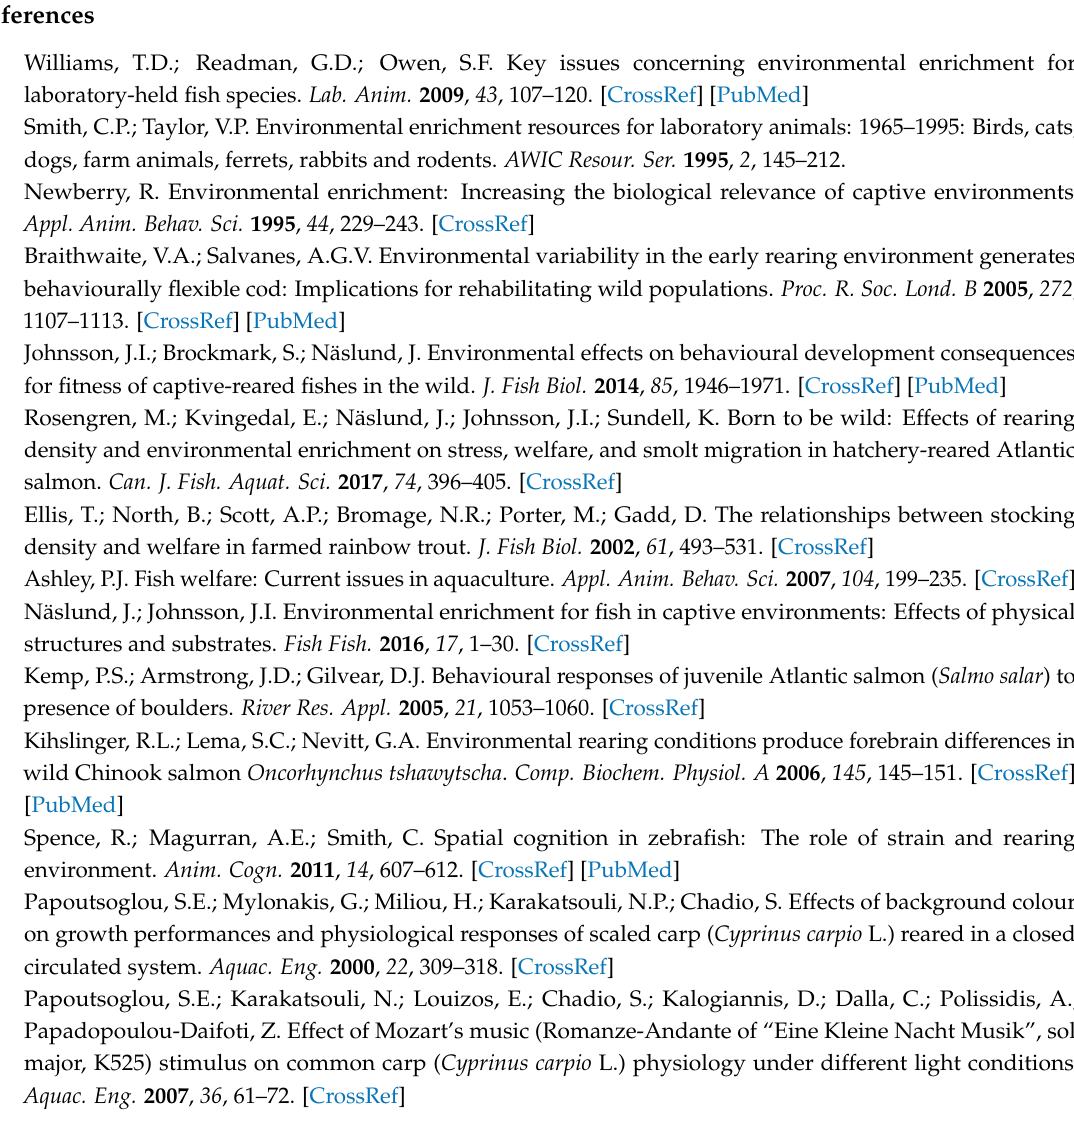
Table S1: Outputs from behavioural generalised linear mixed-effect models of 1) aggression, 2) boldness, and 3) activity, Table S2: Model outputs of 1) egg number (mean), and 2) proportion of eggs